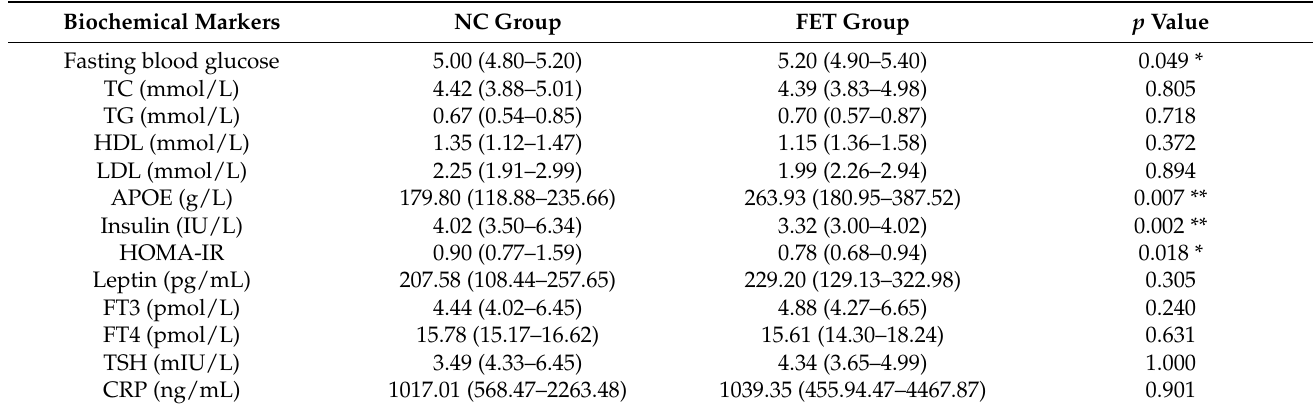
Table 2. Comparison of plasma biochemical markers between the FET group and NC